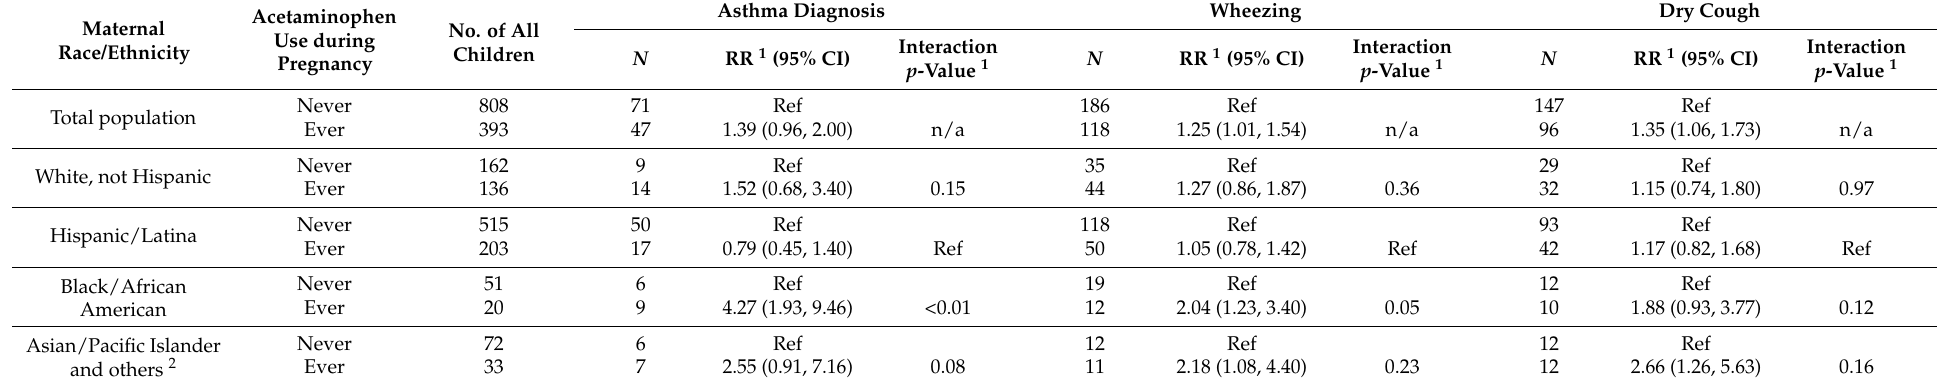
Table 2. Risk ratio (RR) and 95% confidence interval (CI) for asthmatic outcomes in early childhood according to maternal prenatal acetaminophen use, stratified by maternal self-identified